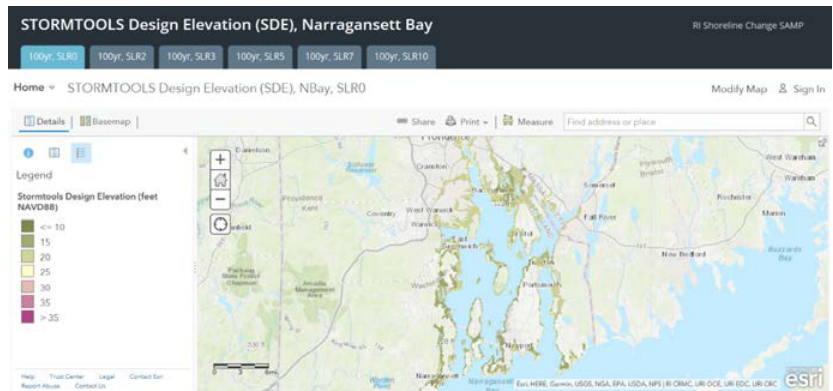
Figure 10. User interface for the STORMTOOLS Design Elevation Maps, Narragansett Bay. The case selected was the 100-yr event with no SLR. (https: // crc-uri.maps.arcgis.com / apps / MapSeries / index. html?appid = 9b85db9b7aaa400cac1a3cb404a96be8, accessed on 16 October